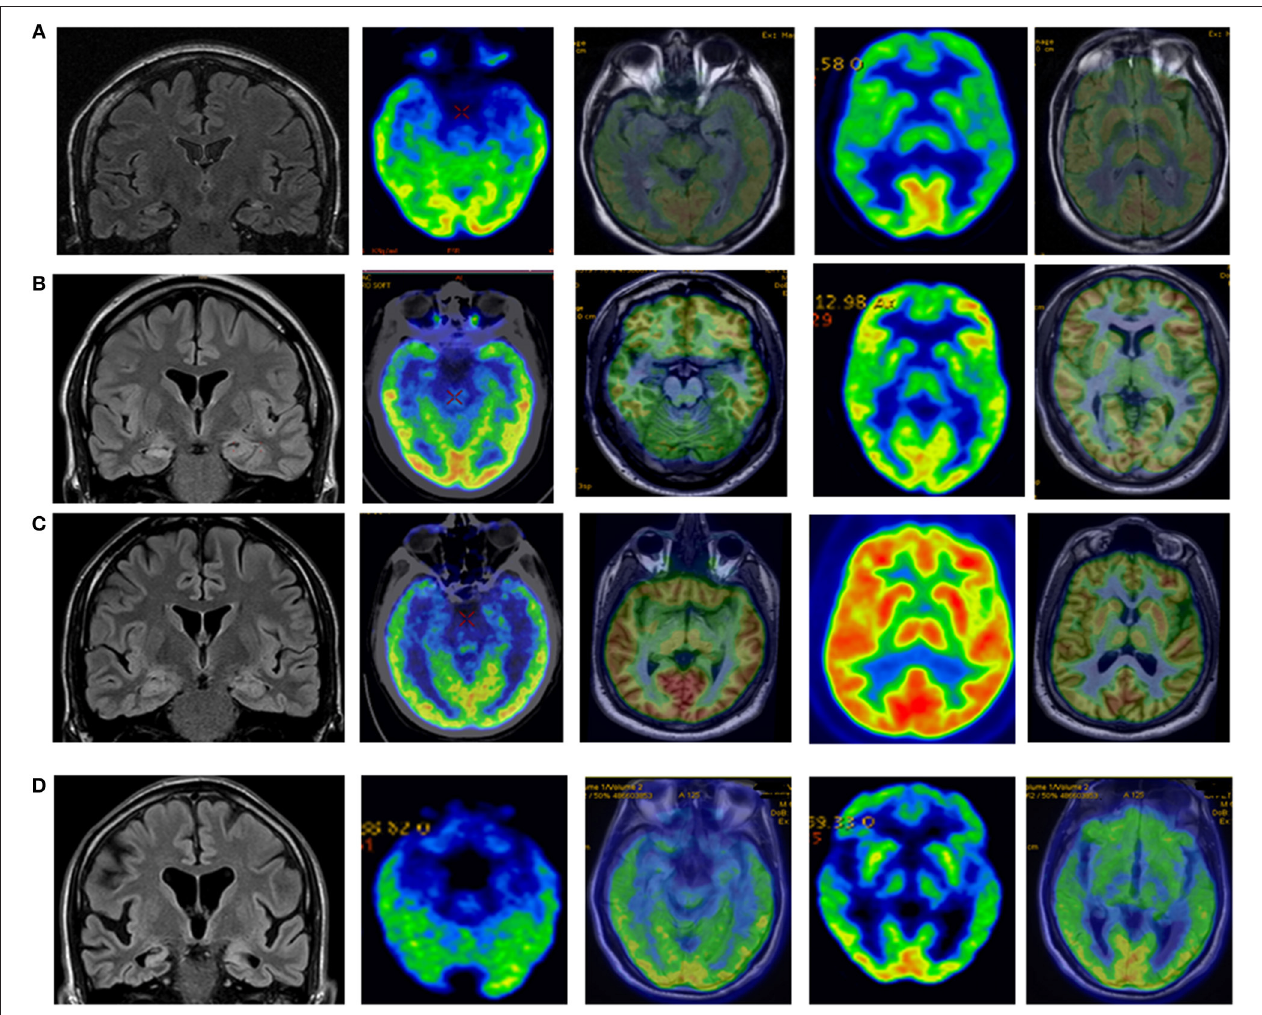
FIGURE 3 | (A) Control patient who suffered measles encephalitis at 2. Epilepsy started at 8. Currently (more than 20 years later) suffers weekly seizures and severe memory deficits. MRI shows bilateral hippocampal atrophy and FDG PET bilateral medial temporal lobe hypometabolism with normal insular metabolism. (B) Control patient who suffered febrile seizures. Epilepsy started at 9. He suffered weekly FIAS preceded by non-specific sensation. MRI right hippocampal hyperintensity and FDG-PET right mesial hypometabolism with normal insular metabolism. (C) Patient with T1DM from age 29 and temporal lobe epilepsy from age 30. MRI remains normal after 5 years but FDG-PET shows bilateral medial temporal lobe hypometabolism and left insula hypometabolism. (D) Patient with epilepsy from age 56. Seizure-free but progressive and severe memory decline. MRI shows bilateral hippocampal sclerosis and insular atrophy, and FDG-PET shows bitemporal medial hypometabolism and bilateral insular